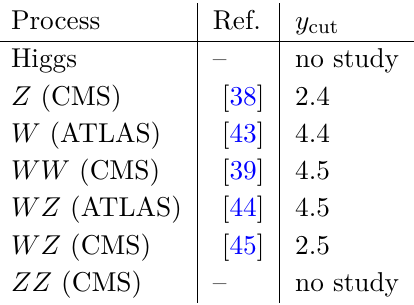
Table 3 . Jet rapidity cuts applied in the experimental studies examined later in this